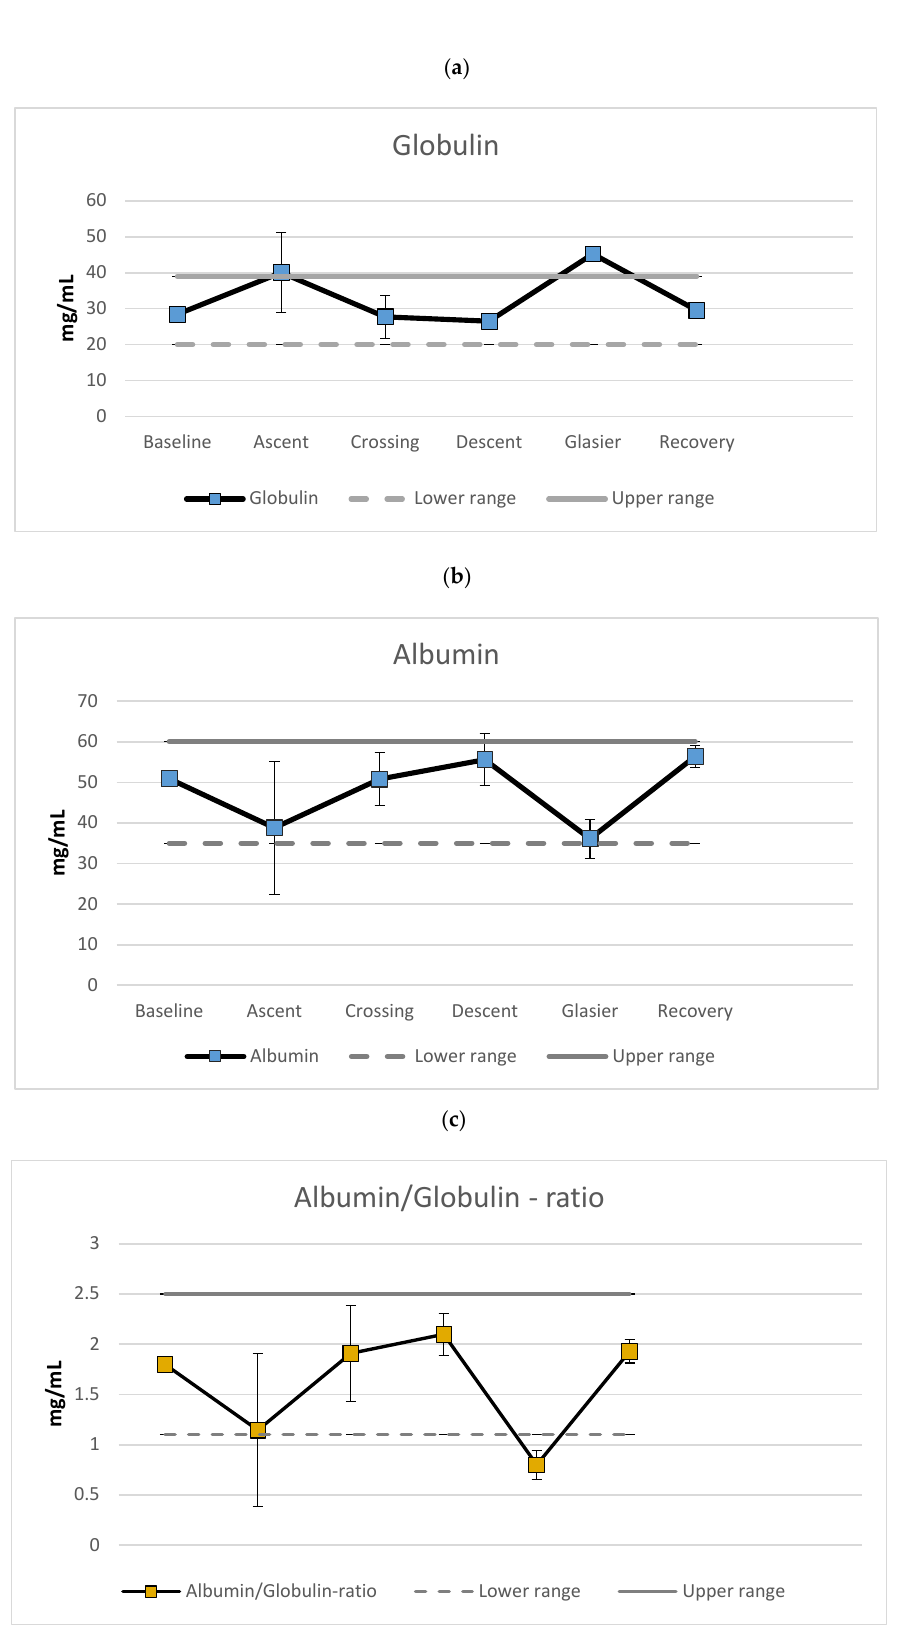
Figure 2. Mean levels of ( a ) globulin, ( b ) albumin and ( c ) the albumin/globulin-ratio (mg/mL) separated for the different phases of the expedition. Error bars represent standard deviations.